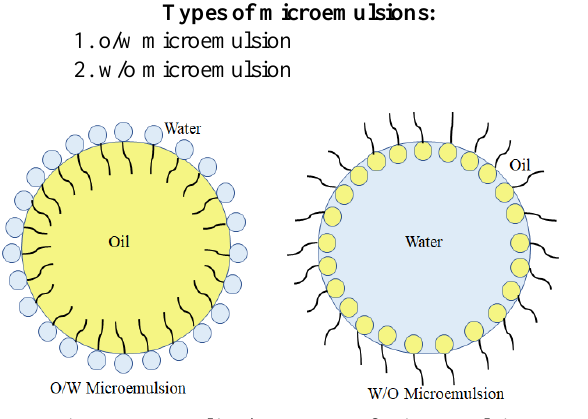
Fig. 11. Generalized structure of microemulsion